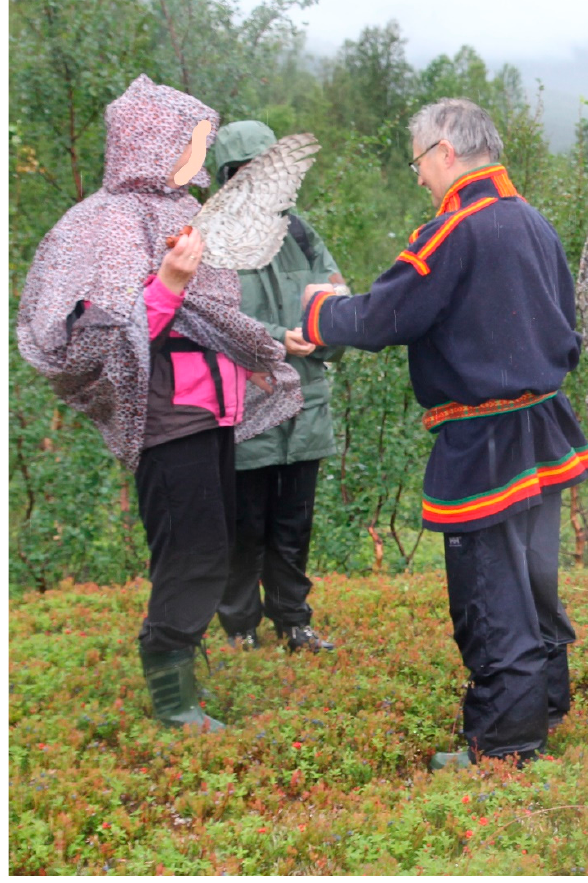
Figure 5. Ritual at the Rikkagallo sieidi using the wing of a bird (Photo: Suzie Thomas).